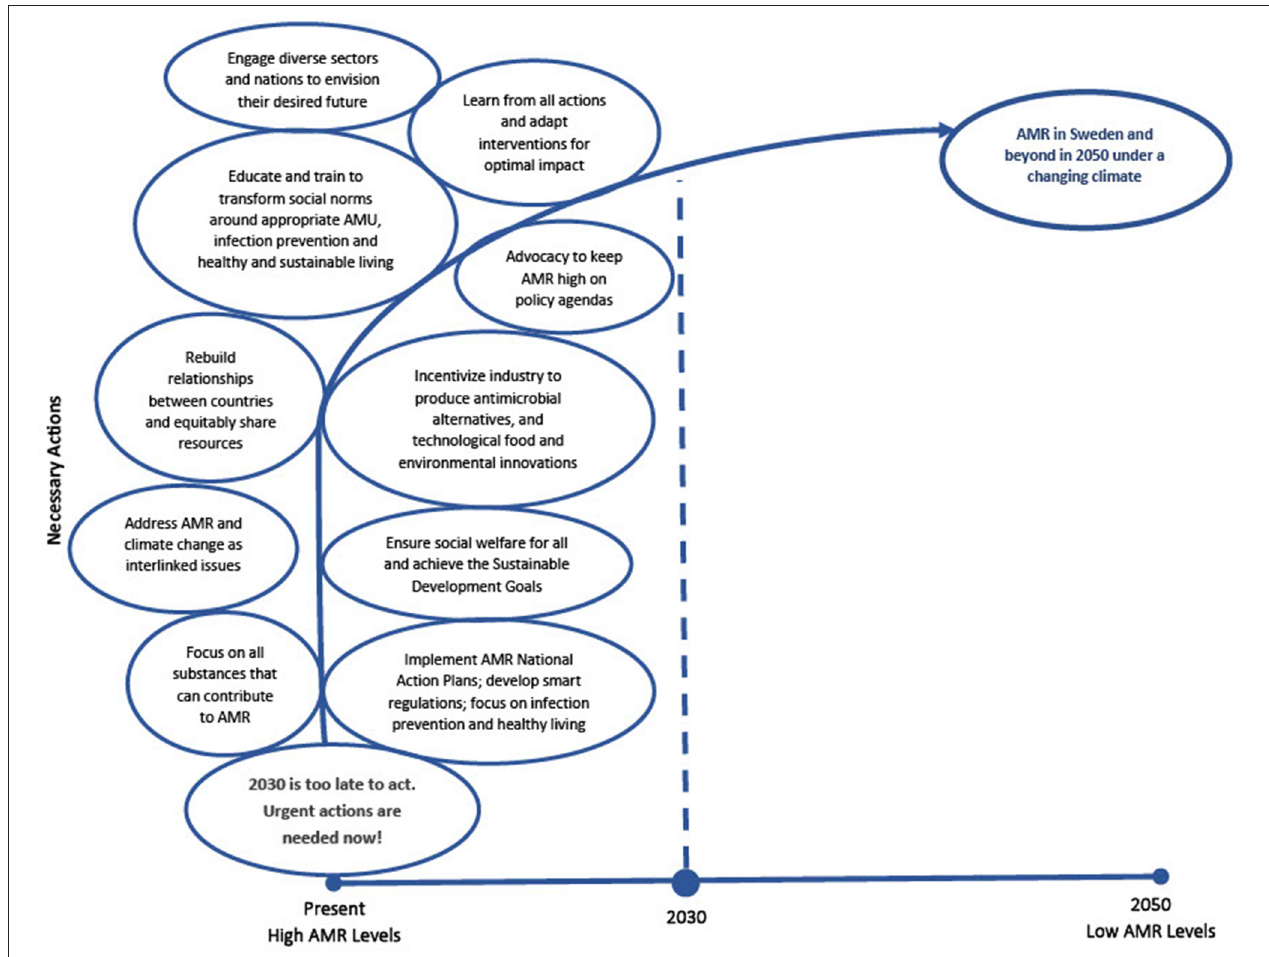
FIGURE 2 | Actions to take in 2030 to address AMR in